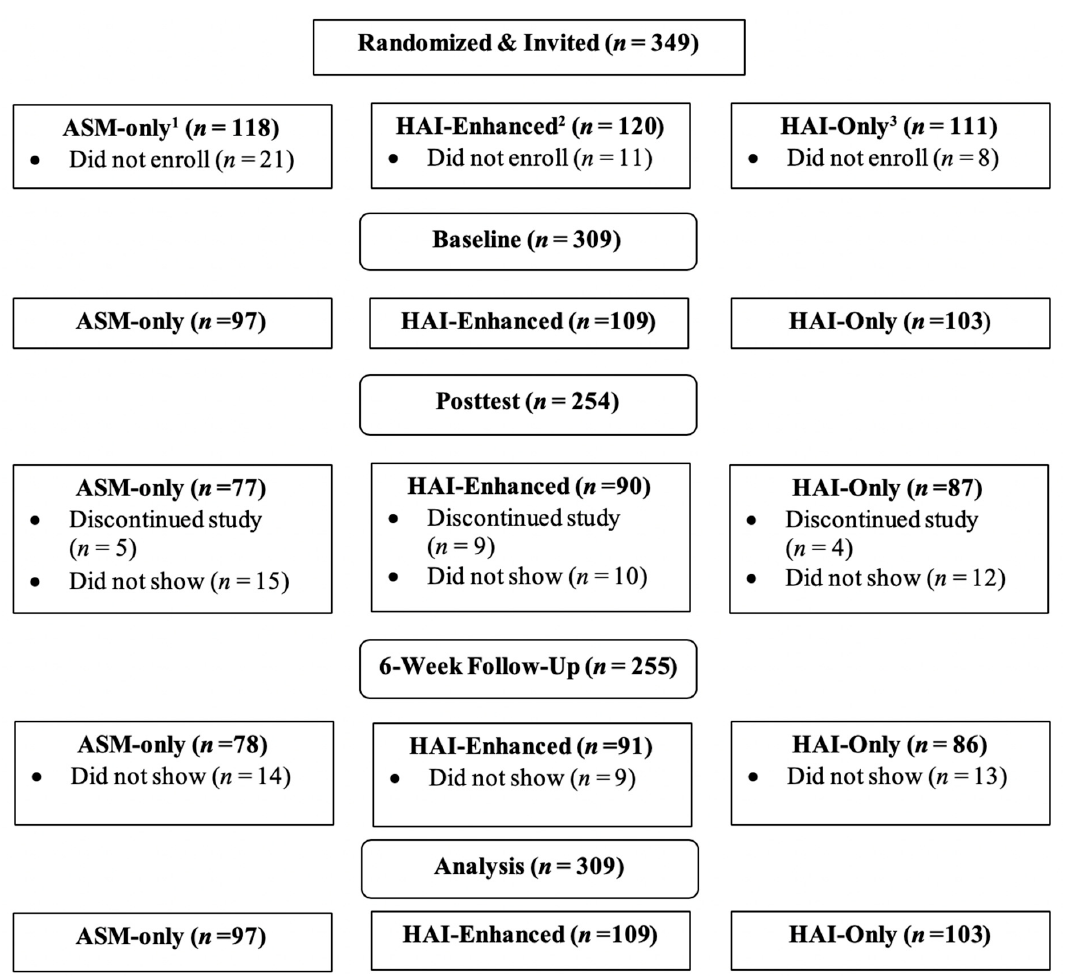
Figure 1. Flow Diagram describing sample randomization, program participation and study completion. 1 Academic Stress Management (100% content; 0% HAI); 2 Human-Animal Interaction— Enhanced (50% content; 50% HAI); 3 Human-Animal Interaction only (0% content; 100% HAI). See 2.3 for more information.